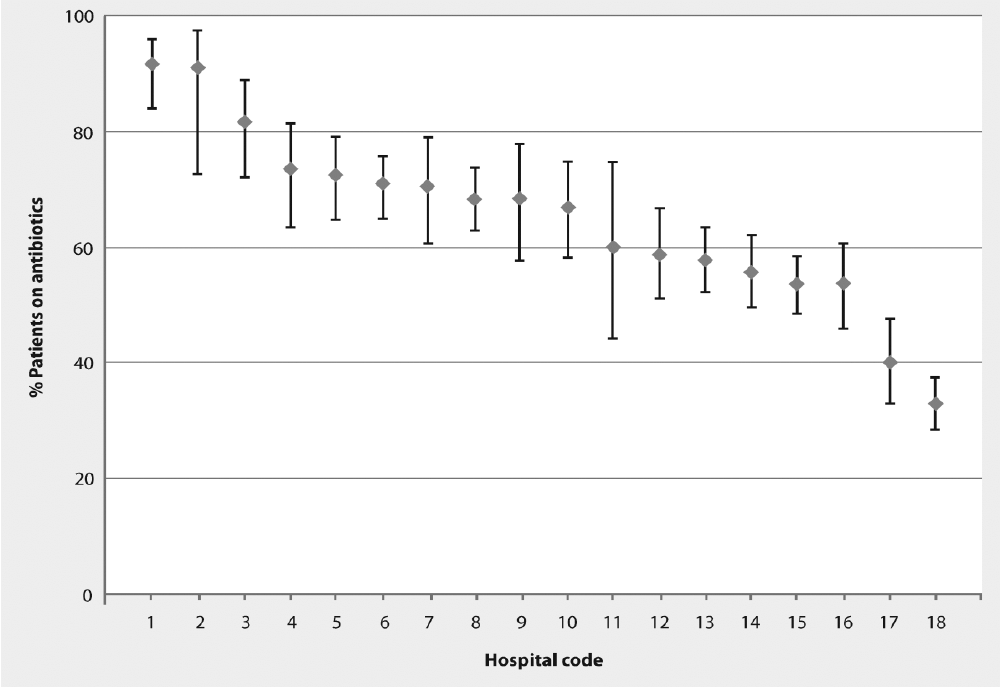
Figure 1. Percentage of patients in 18 Egyptian hospitals receiving antibiotics presented as actual measured percentage (diamond) with 95% confidence intervals (vertical